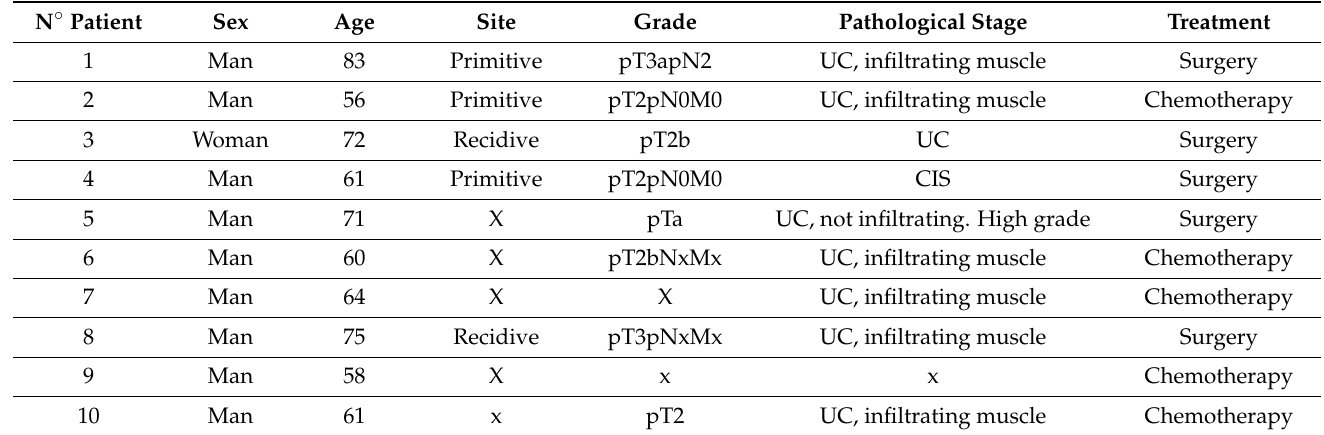
Table 1. Patient characteristics. UC, urothelial carcinoma; CIS, carcinoma in